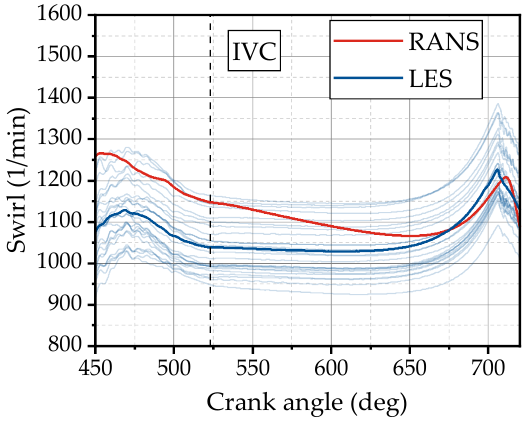
Figure 5. Swirl within the cylinder during the compression stroke predicted by RANS and LES.